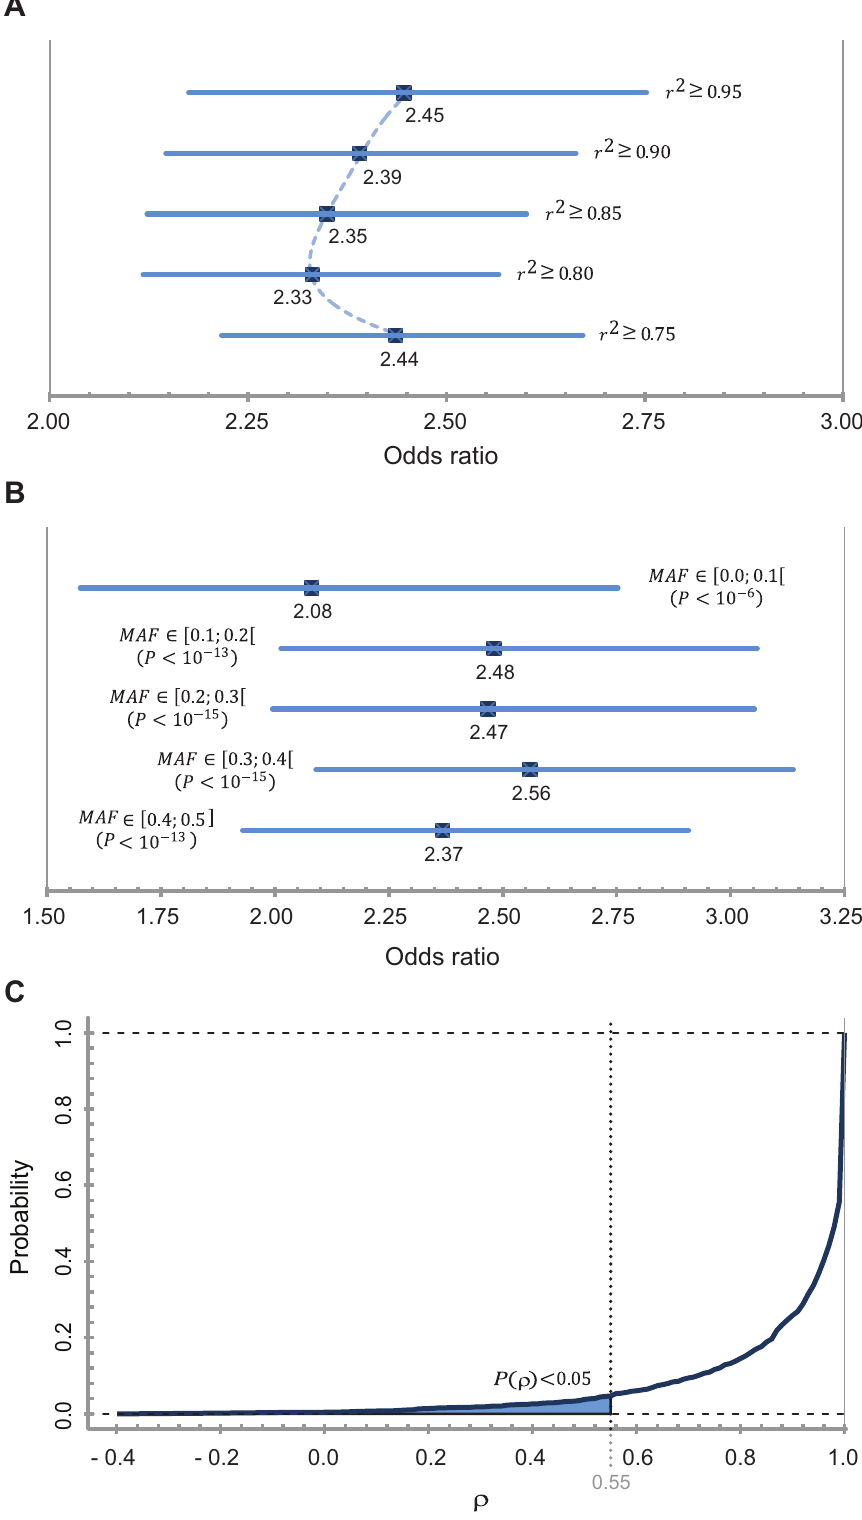
Figure 1. Statistical analysis of 3 9 -UTR enrichment values and determination of the folding correlation coefficient threshold. A: SNP enrichment in the 3 9 -UTR in dependency of different LD thresholds. Displayed are the ORs and confidence intervals for five cut-offs. Accumulative 3 9 - UTR SNP sets were calculated. The fitted distribution (dashed line) points out the stabilization of the OR around a threshold of 0.8. B: SNP enrichment in the 3 9 -UTR in dependency of the minor allele frequency. Displayed are the ORs and confidence intervals for the 5 different MAF bins. SNP counts were compared within the respective bins. C: Probability distribution of correlation coefficients ( p ) between wild-type and mutated structures